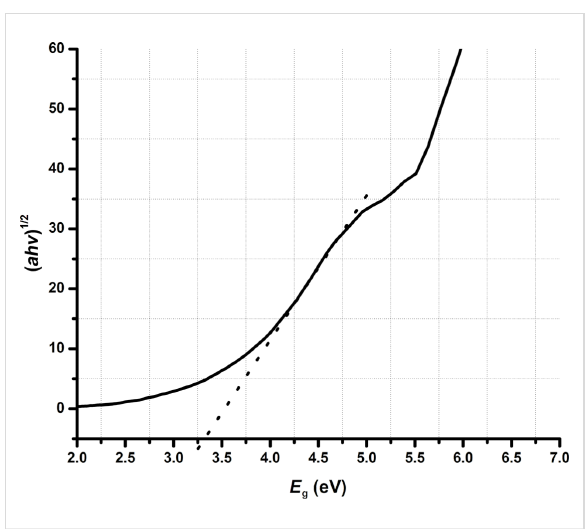
Figure 5: Solid-state diffuse reflectance UV–vis spectrum and extrapo- lation of the band gap energy of Ta 2 O 5 nanoparticles prepared from Ta(OEt) 5